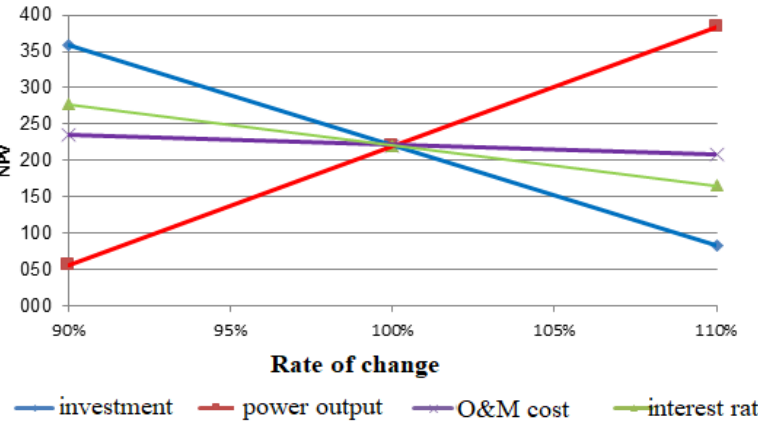
Figure 5. Sensitivity analysis results.